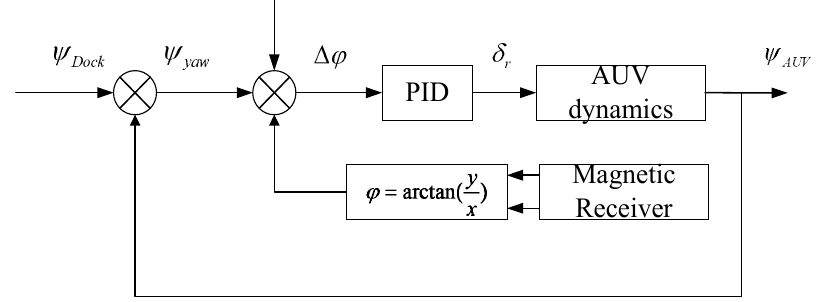
Figure 9. AUV motion control diagram.